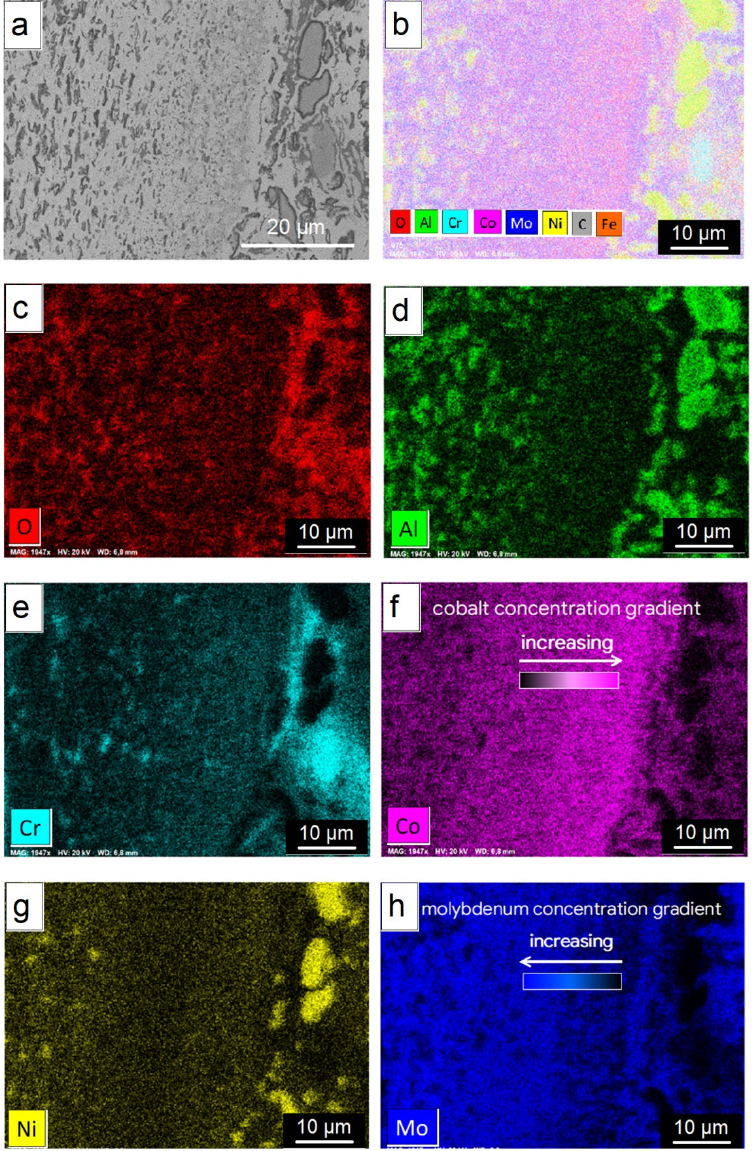
Figure 12. Microstructure image and elements’ distribution maps in the gradient area: ( a ) microstructure, ( b ) all elements, ( c ) O, ( d ) Al, ( e ) Cr, ( f ) Co, ( g ) Ni, ( h ) Mo . Thus, the structure of the NiAl–CrMoCo alloy obtained in this work was a matrix containing nanoscale lamellar phases crossing each other. An acicular phase